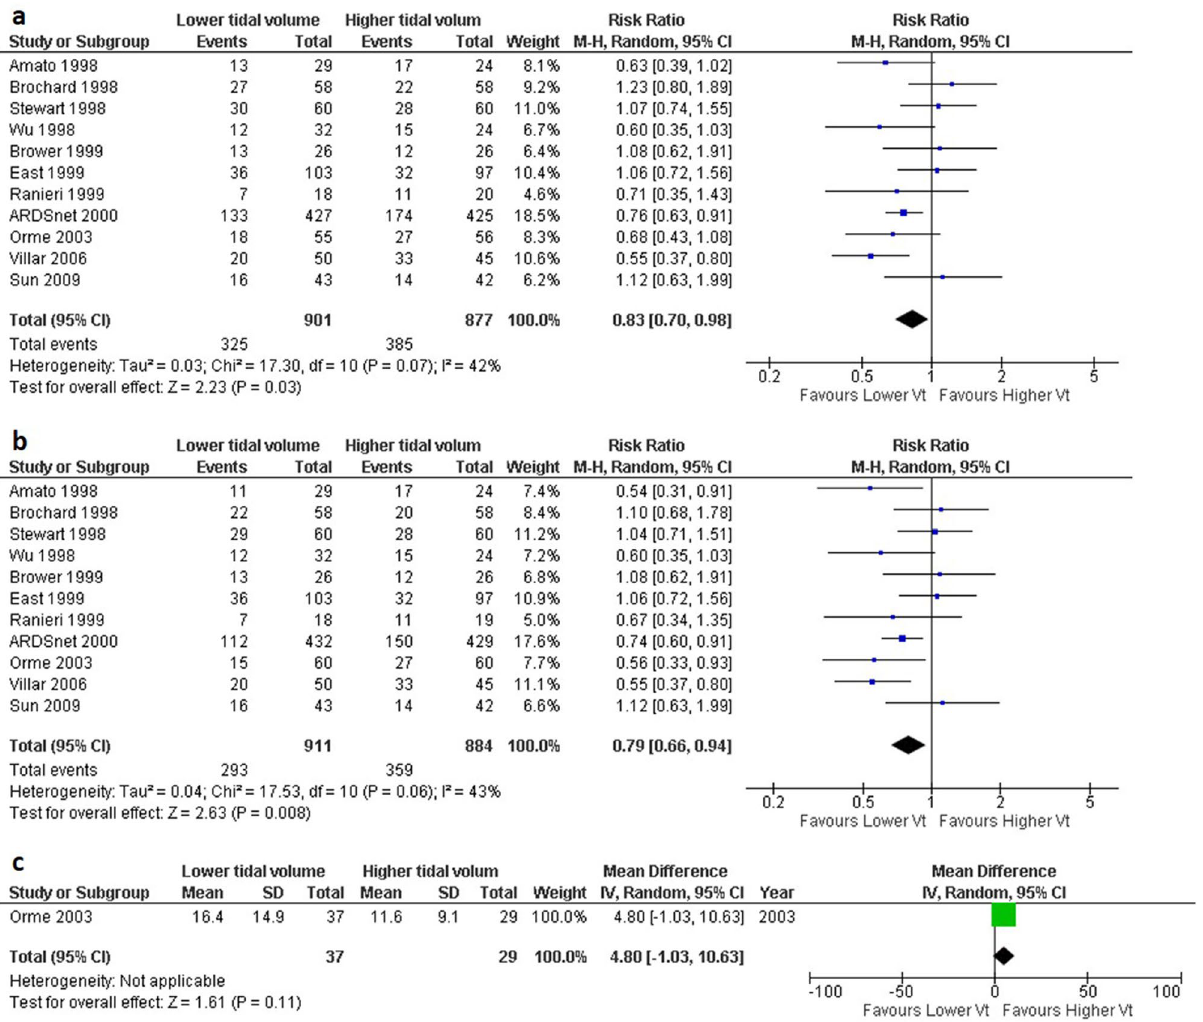
Figure 3. Forest plot showing the comparison of low tidal volume ventilation (LTV; 4–8 ml/kg) versus high tidal volume ventilation (HTV; > 8 ml/kg) for mortality and QOL. ( a ) 28-day mortality. Data extracted from the Kaplan–Meier curve at 28 days; Brochard 1998, Stewart 1998, ARDSnet 2000, and Villar 2006, in-hospital mortality; Wu 1998, East 1999, Brower 1999, and Orme 1999, 28-day mortality; the other studies. ( b ) the longest follow-up mortality. Data extracted from the Kaplan–Meier curve at 28 days; Villar 2006, 28-day mortality; Ranieri 1999, Sun 2009, 60-day mortality; Brochard 1998, 1-year mortality; Orme 2003. In-hospital mortality; other studies ( c ) quality of life (sickness impact profile) CI confidence interval; M–H Mantel–Haenszel method, IV inverse variance, QOL quality of